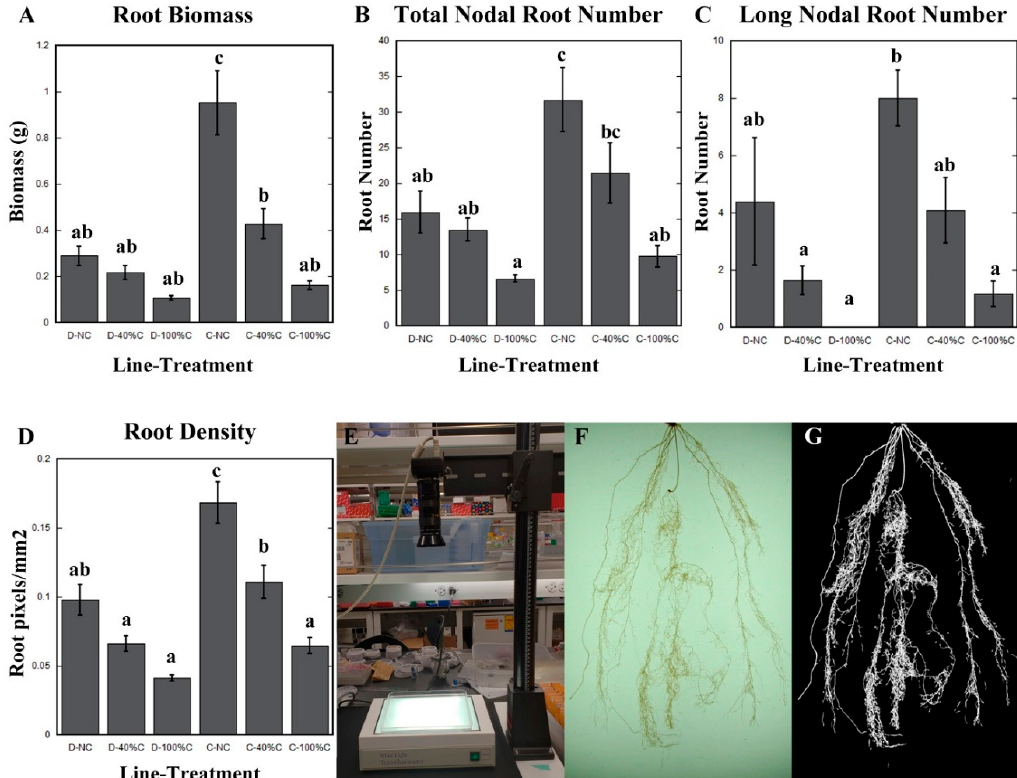
Figure 2. Effect of defoliation on selected root traits of two winter wheat cultivars. ( A ) Root biomass. ( B ) Total nodal root number. ( C ) Long (> 38 cm) nodal root number. ( D ) Root density calculation based on occupancy analysis. ( E ) Roots were spread in a plastic tray illuminated from above to obtain photos with high contrast. The camera was mounted on a vertical stand to acquire images of the whole root system. ( F ) Representative pictures of the first 20 cm of the root of a 10-week-old wheat plant, obtained with the system shown in ( E ). ( G ) Corresponding segmented image of the roots in ( F ) for measuring root density. No leaves clipped = NC, 40% of the leaves clipped = 40% C, and 100% of the leaves clipped = 100% C. Duster = D and Cheyenne = C. Error bars represent standard error of the mean. N ≥ 13 ten-week-old plants. Statistically significant differences of the means were determined using One-way ANOVA and Tukey’s tests. Different letters represent distinct means within groups at p < 0.05.